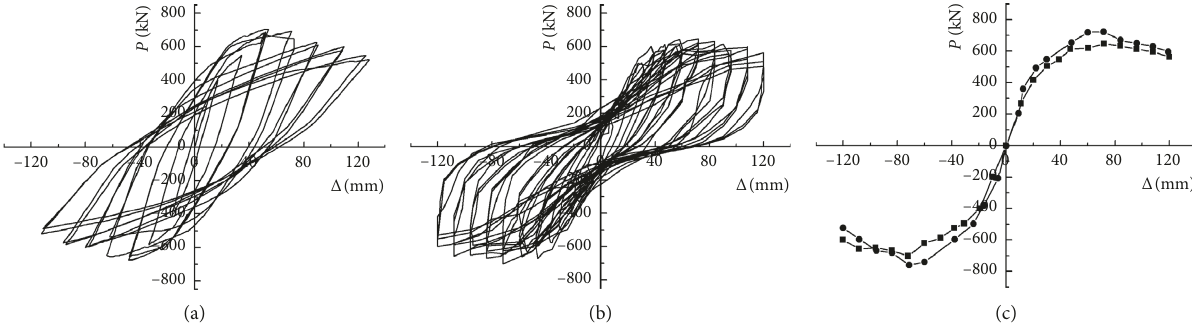
Figure 11: Comparison of finite element analysis curves with experimental ones. (a) Hysteretic curve in ABAQUS. (b) Hysteretic curve in test. (c) Skeleton curve comparison.